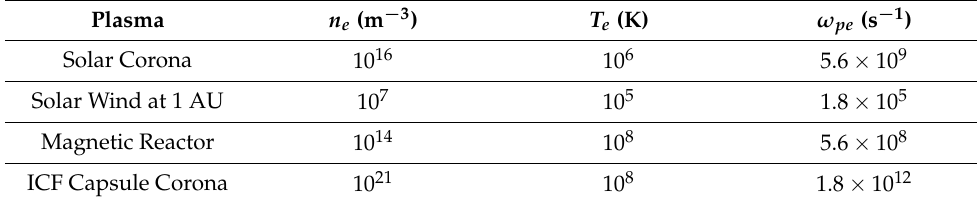
Table 2. Temperature, electron densities and typical electron plasma frequency values for different plasma